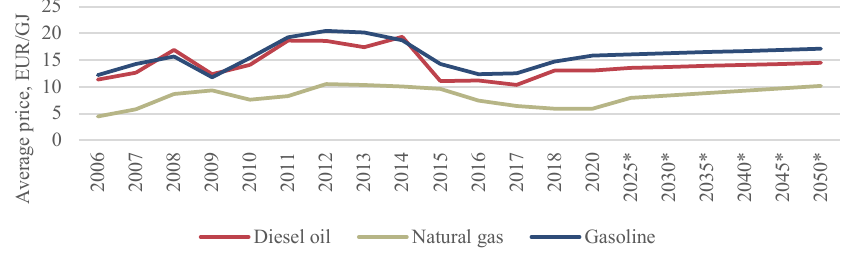
Fig. 6. Average prices of primary energy resources[28] used in the transport sector and